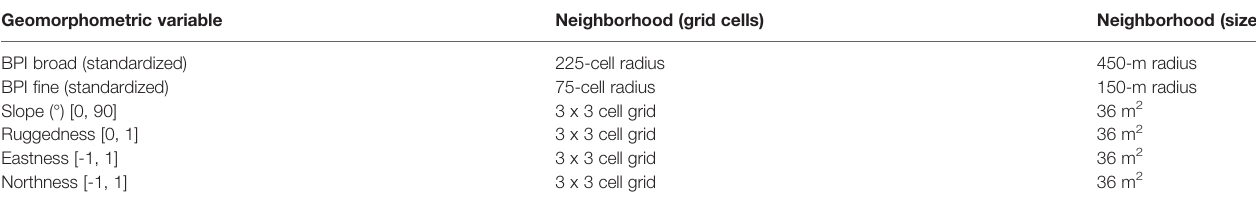
TABLE 2 | Settings used to estimate six geomorphometric variables in the Benthic Terrain Modeler (BTM) 3.0 ArcMap plug-in. Geomorphometric